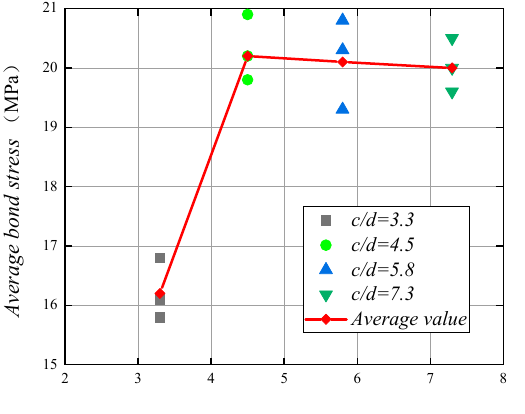
Figure 10. Bond stress and the ratio of concrete cover to reinforcing steel diameter relationship curve.